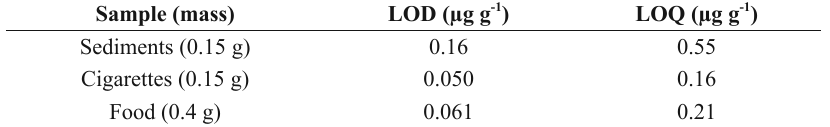
Limits of detection and quanti fi cation based on sample mass calculated for samples of sediments, cigarettes and food.